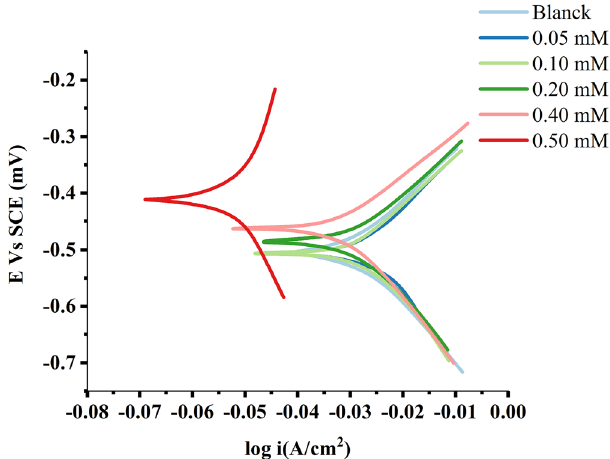
Figure 13. Potentiodynamic polarization curves for MS in 1.0 M HCl with different concentrations of nonanedihydrazide at 303